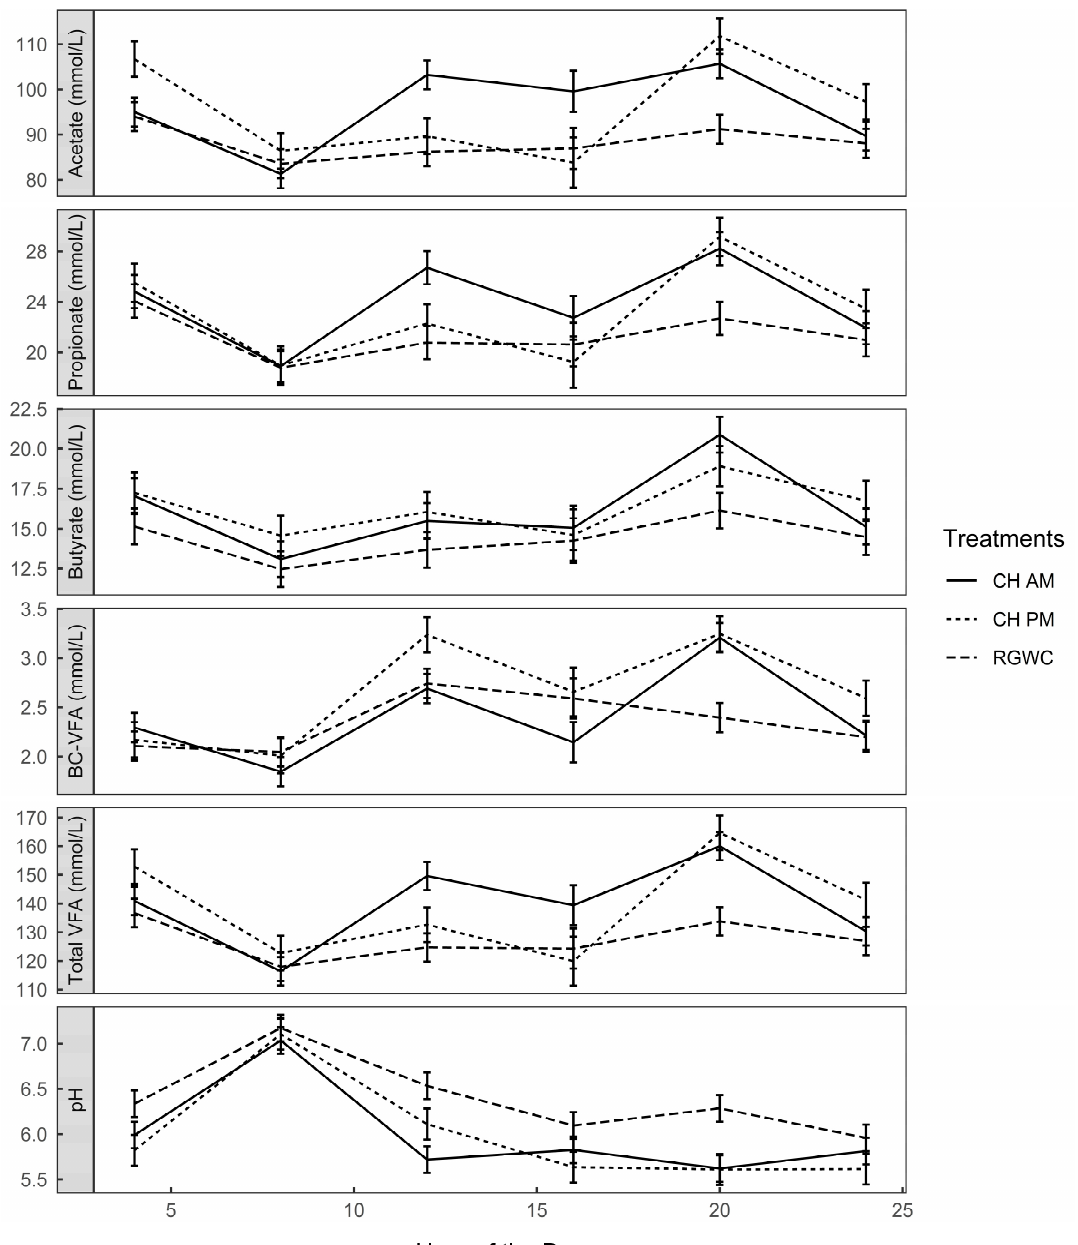
Figure 3. Diurnal variation of rumen fermentation parameters. Solid lines denote CHAM (ryegrass / whiteclover + morningallocationofchicory), shortdashedlinedenotesCHPM(ryegrass / white clover + afternoon allocation of chicory), and long dashed line denote RGWC (perennial ryegrass / white clover only). BC-VFA (branched chain-volatile fatty acids; iso-valerate + iso-butyrate). Error bars are standard error of the mean ( n =